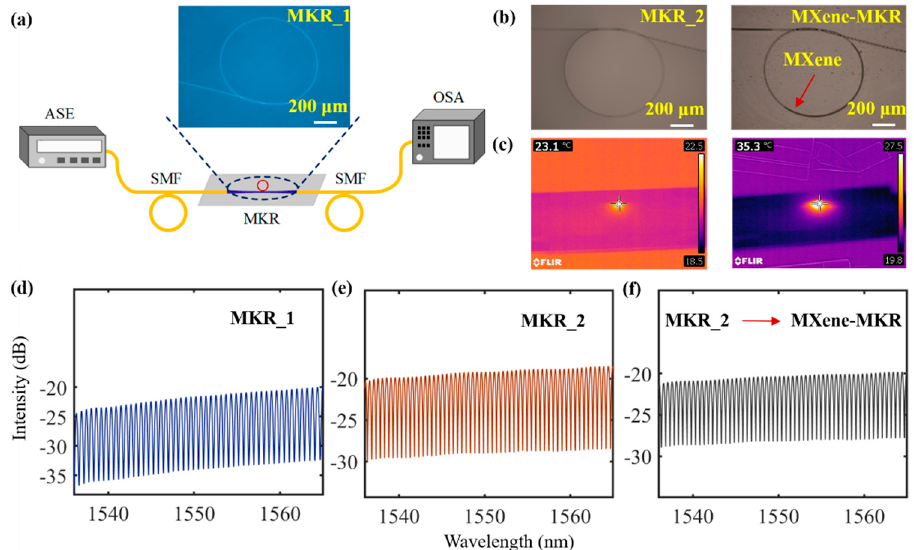
Figure 3. ( a ) Diagram of system apparatus for testing spectral response; ( b ) optical microscope image; ( c ) thermograms of bare MKR and MXene MKR; transmission spectra of ( d ) MKR_1, ( e ) MKR_2, and the ( f ) MXene MKR.